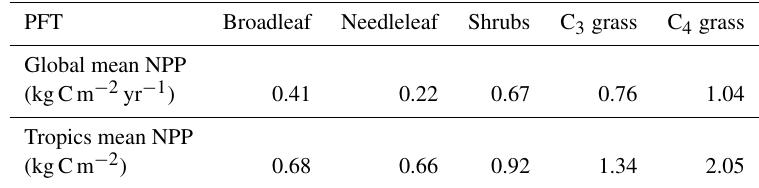
Table A2. Global and tropical average net primary production (NPP) per PFT.